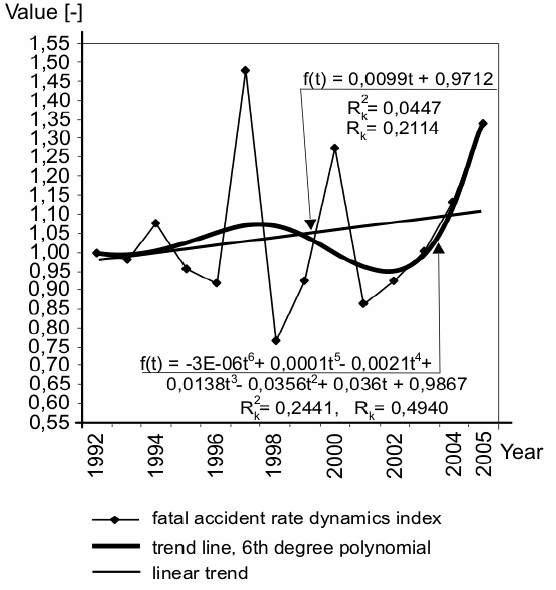
Fig 8. Dynamics of total fatal accident rate in construction in 1992–2005